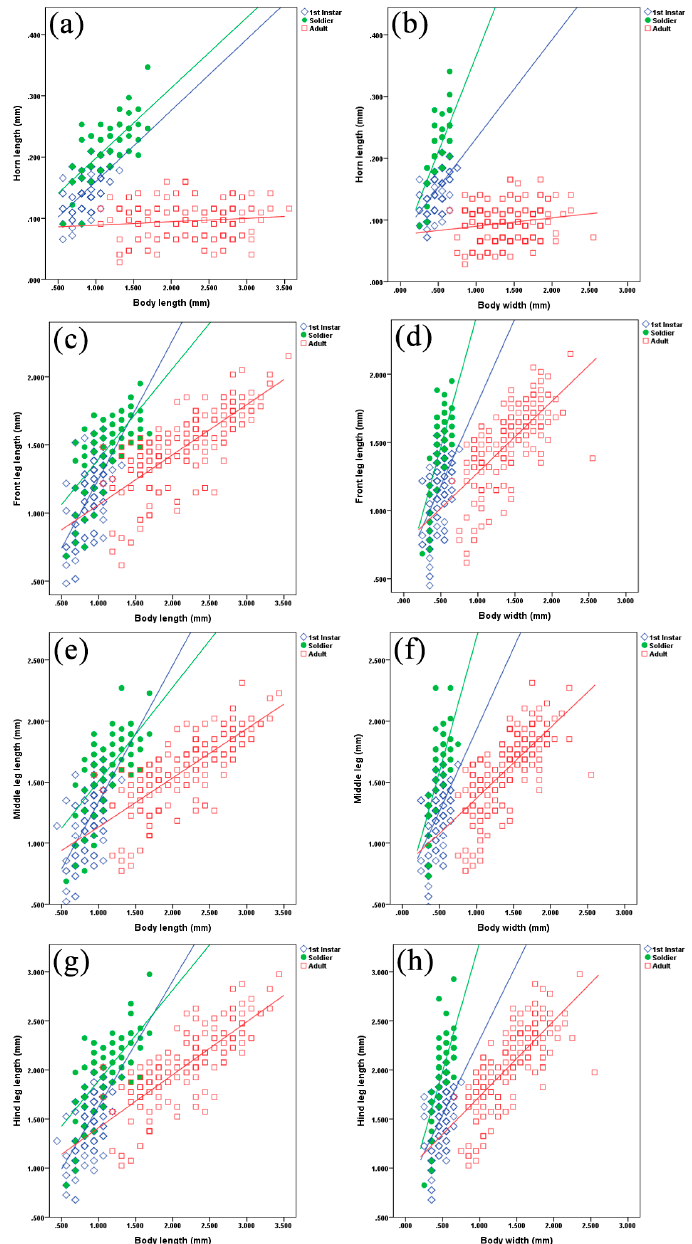
Figure 3. Bivariate scatterplots based on the measurements of different body parts of P. bambucicola first instars, soldiers, and adults. ( a ) Horn length vs. body length; ( b ) horn length vs. body width; ( c ) front leg length vs. body length; ( d ) front leg length vs. body width; ( e ) middle leg length vs. body length; ( f ) middle leg length vs body width; ( g ) hind leg length vs. body length; ( h ) hind leg length vs. body width. The open blue diamonds ( ◊ ) indicate first instar nymphs, the green circles ( ● ) indicate soldiers, and open red squares ( □ ) indicate adults.